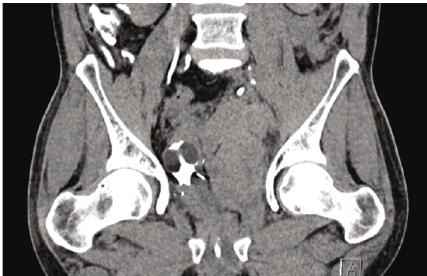
Figure 4: CT pelvis with cystogram at our hospital (coronal): displaced bladder; poor cystogram without